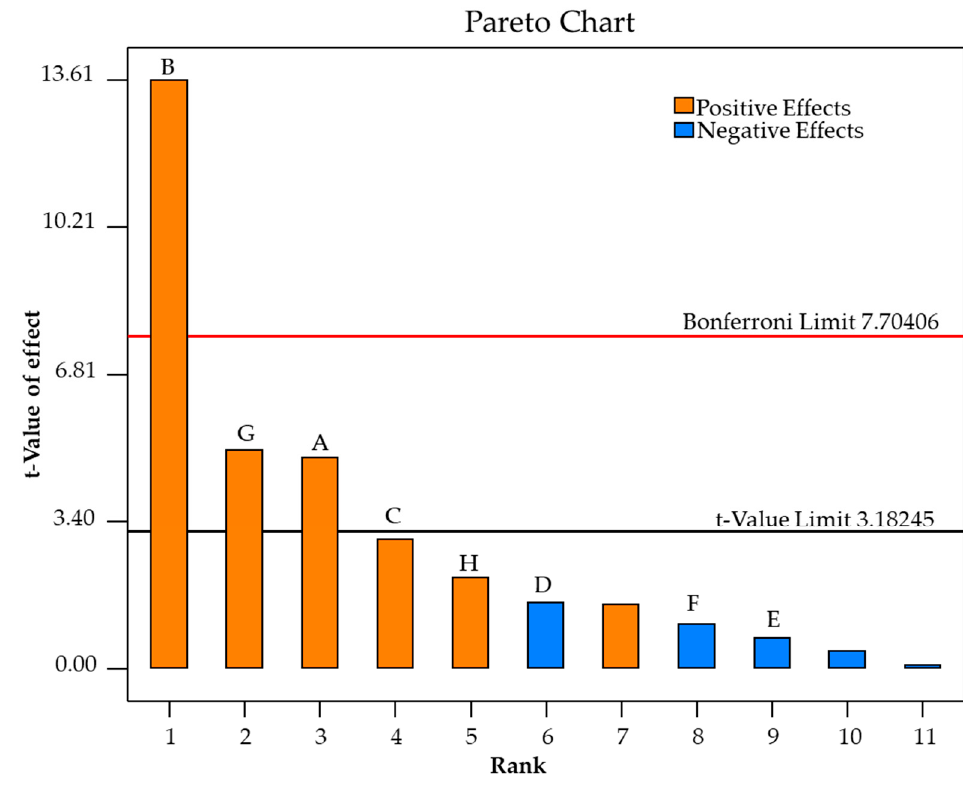
Figure 3. Pareto chart exhibiting effects of (NH 4 ) 2 SO 4 (A); Substrate concentration (B); ZnSO 4 .7H 2 O